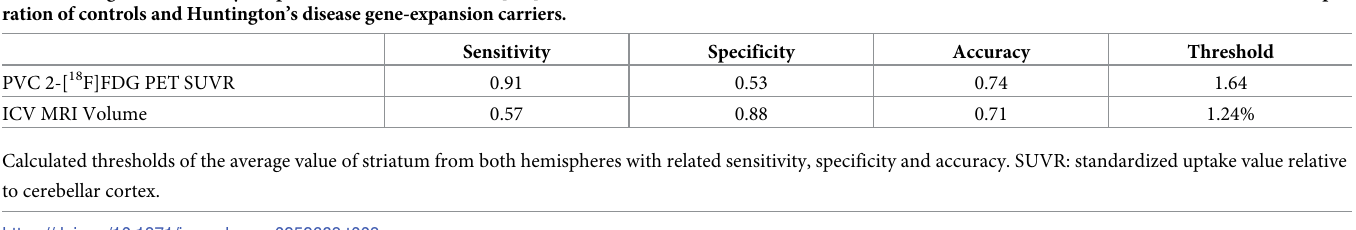
Table 3. Diagnostic accuracy for partial volume corrected 2-[ 18 F]FDG PET SUVR and intracranial volume corrected MRI volume of bilateral striatum for the sepa- ration of controls and Huntington’s disease gene-expansion carriers.